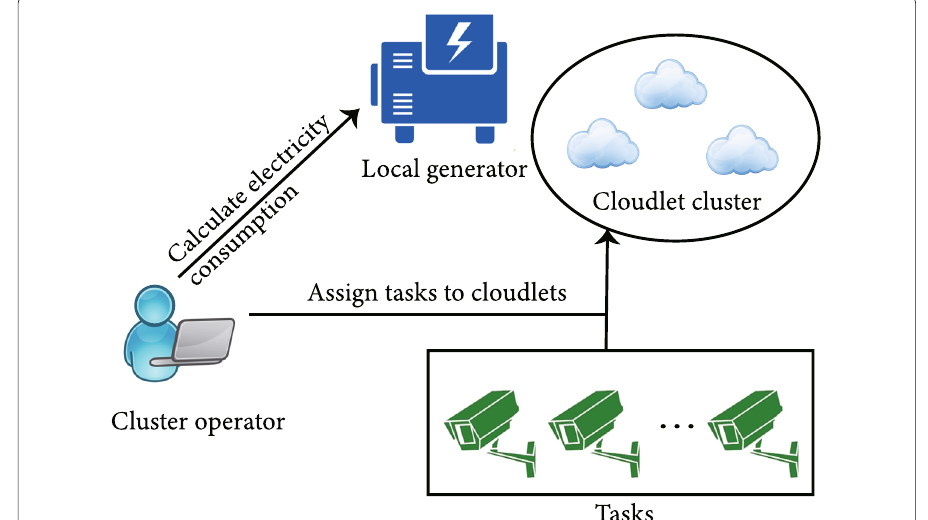
Fig. 2 Task scheduling in the